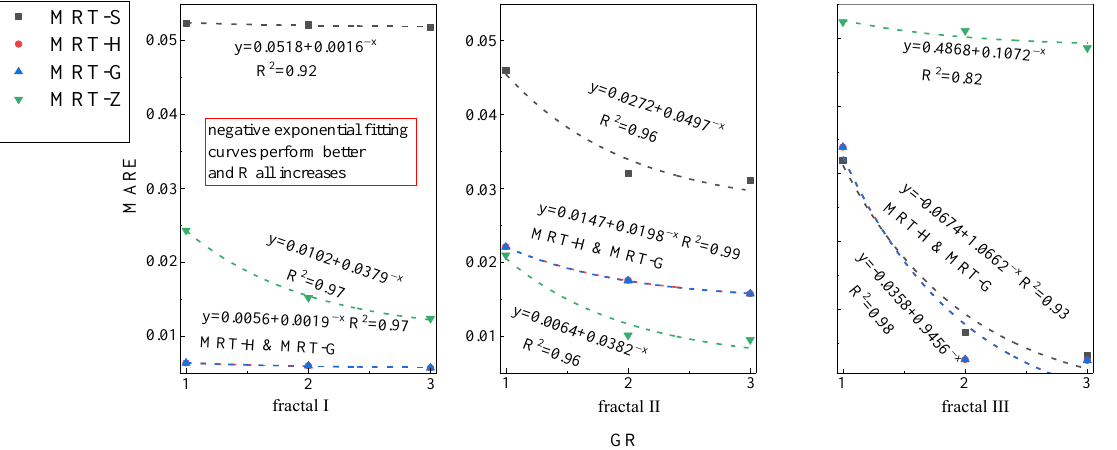
Figure 11. MARE curves of different fractal structures vary with GRs in negative exponential form.